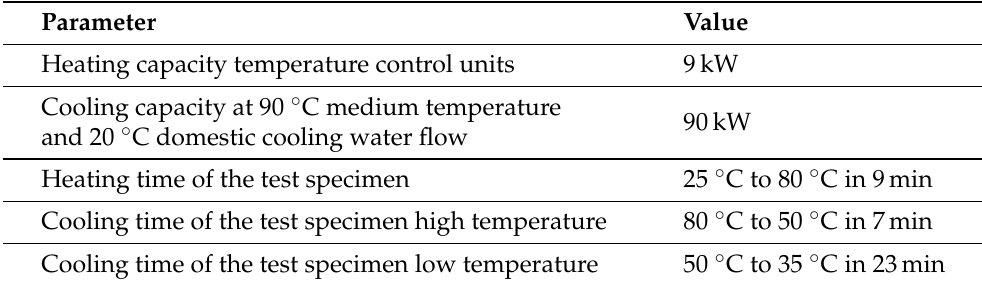
Table 3. Power data of the EM temperature conditioning system.